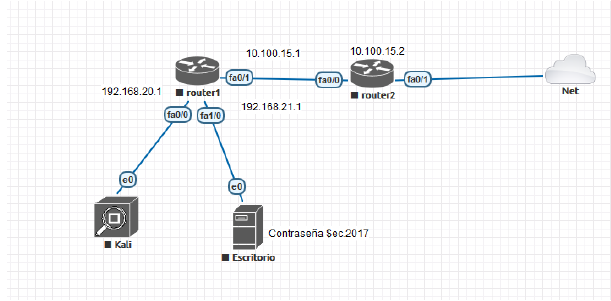
Figure 2. Example of remote-virtual laboratory for auditing local and network